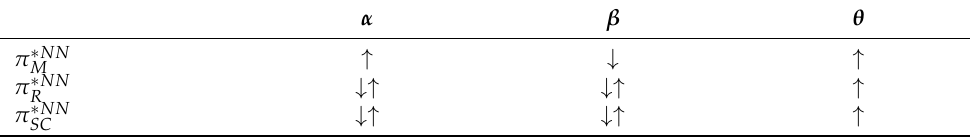
Table 4. The sensitivities of optimal profits to model parameters for Strategy NN. α β θ π ∗ NN